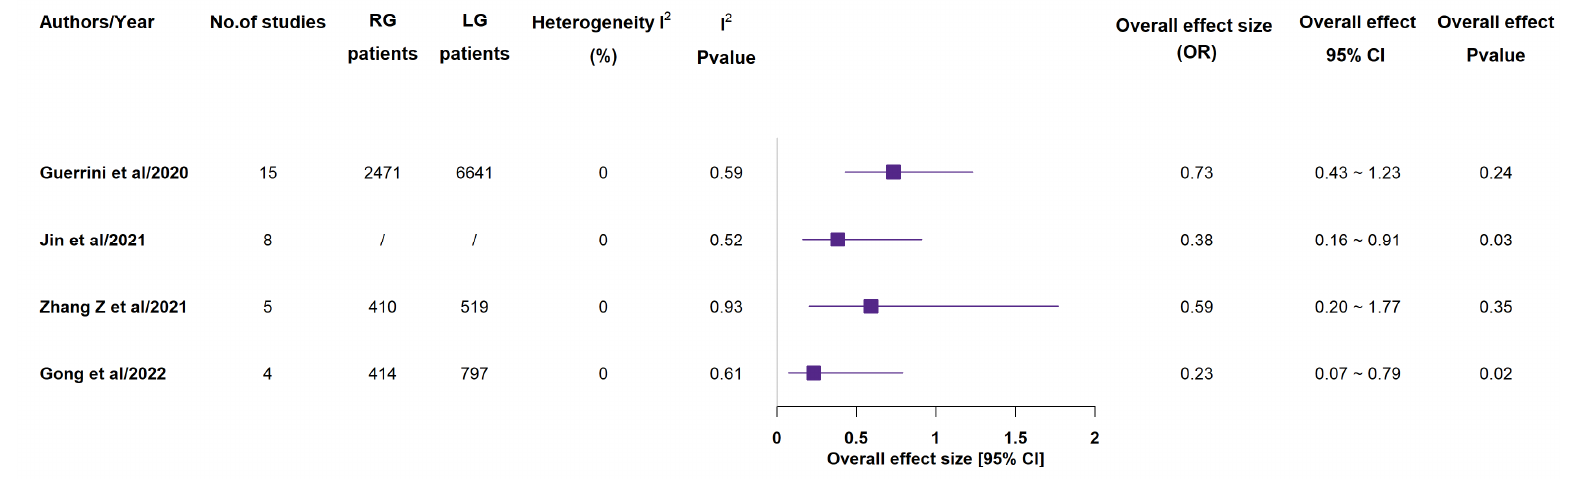
Figure 10. Pancreatic complications rate. RG = Robotic gastrectomy; LG = Laparoscopic gastrectomy; OR = odds ratio [15–17,20].